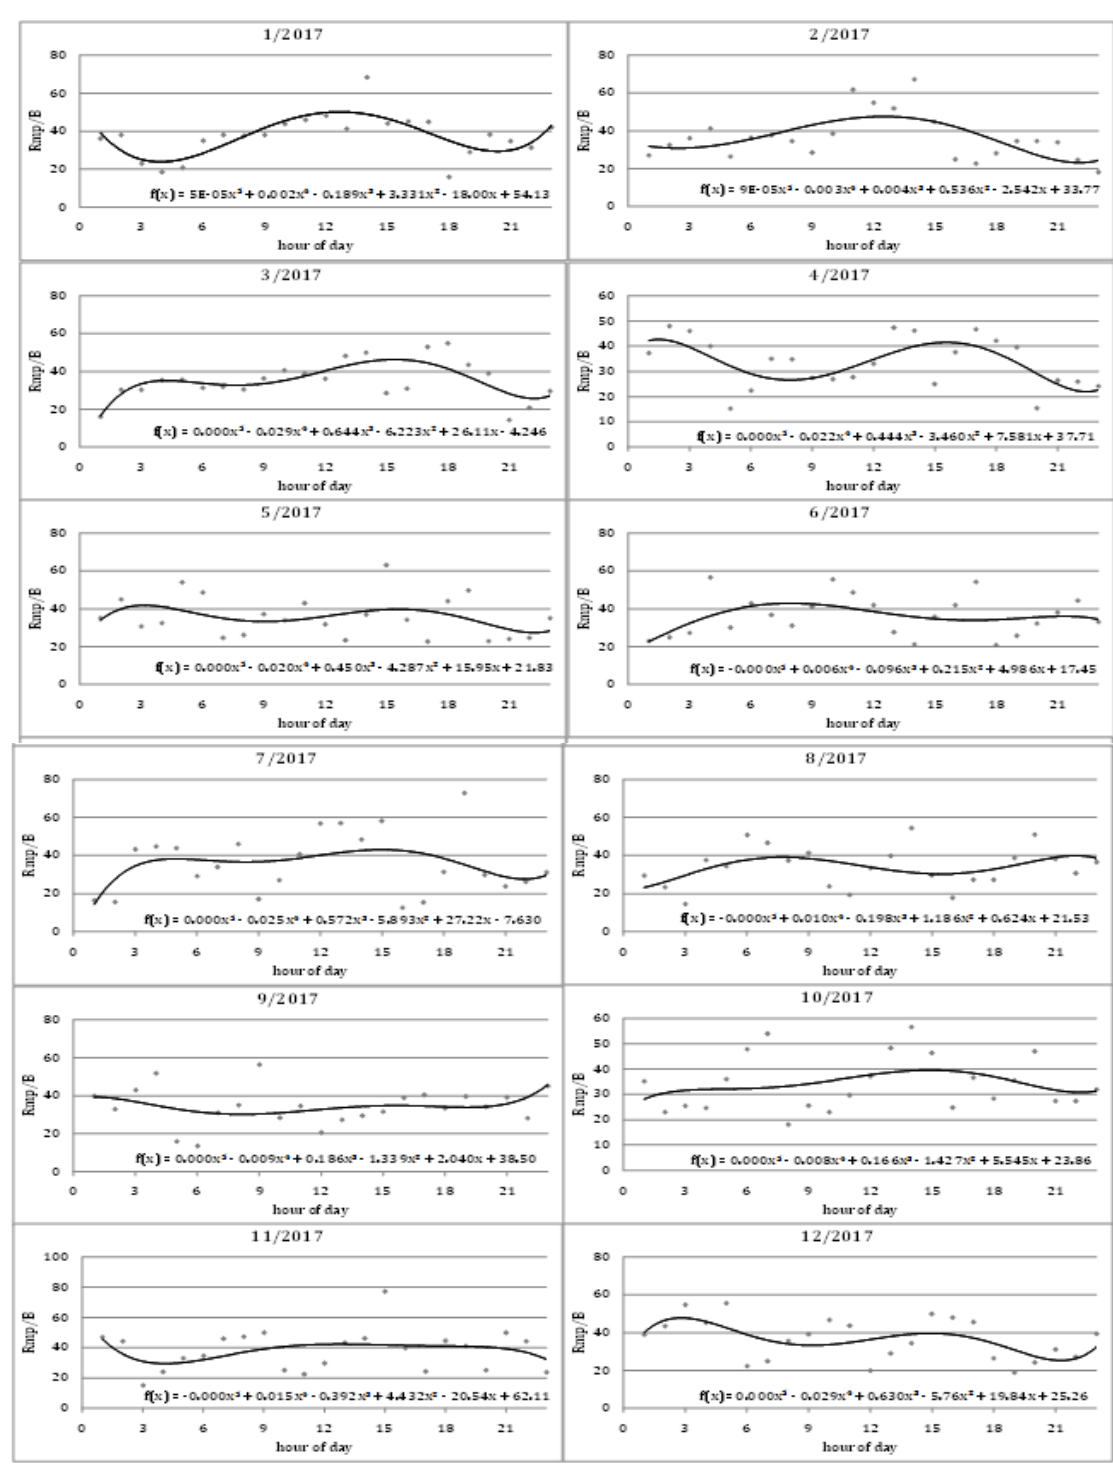
Fig. 4: Monthly median of (R